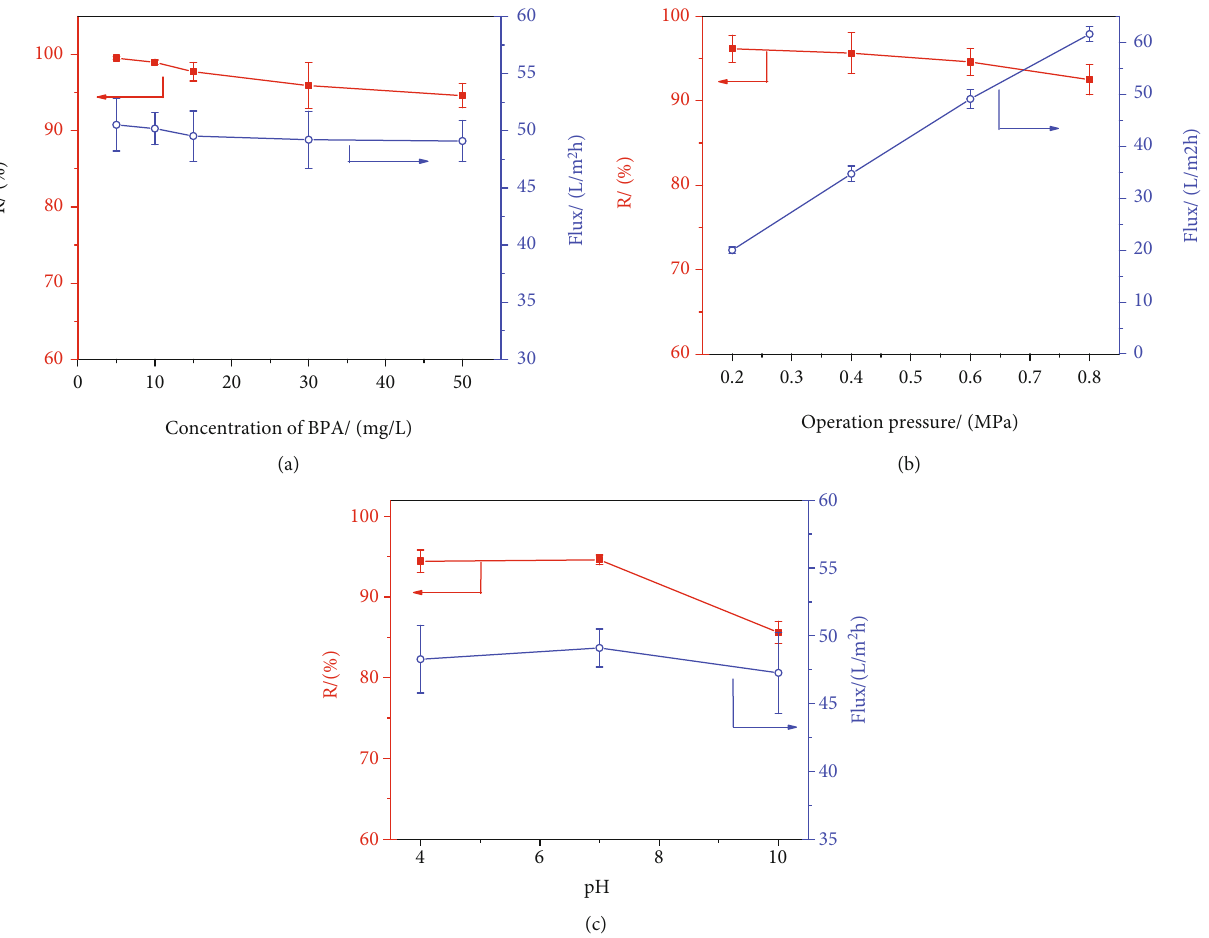
Figure 12: Application of NF-Ag-3 on removing BPA. (a) Concentration, (b) operating pressure, and (c) pH